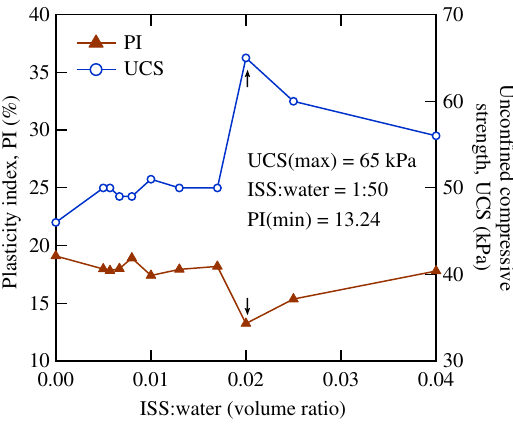
Figure 4. Variation curves of PI and UCS at different ISS:water volume ratio of samples